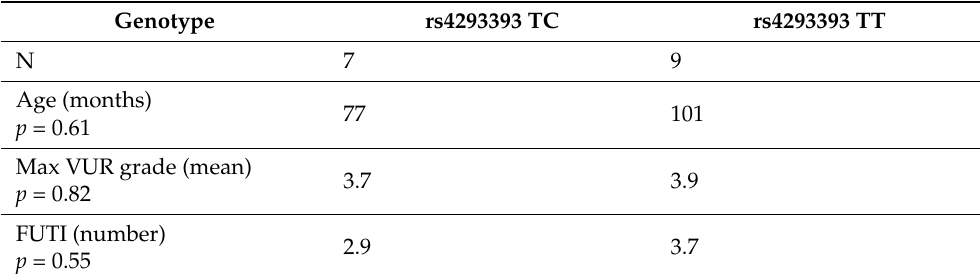
Table 3. Genotype at rs4293393 of Uromodulin in patients with VUR and